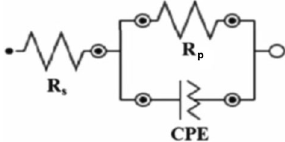
Figure 6. Equivalent circuit model adapted to fit the impedance